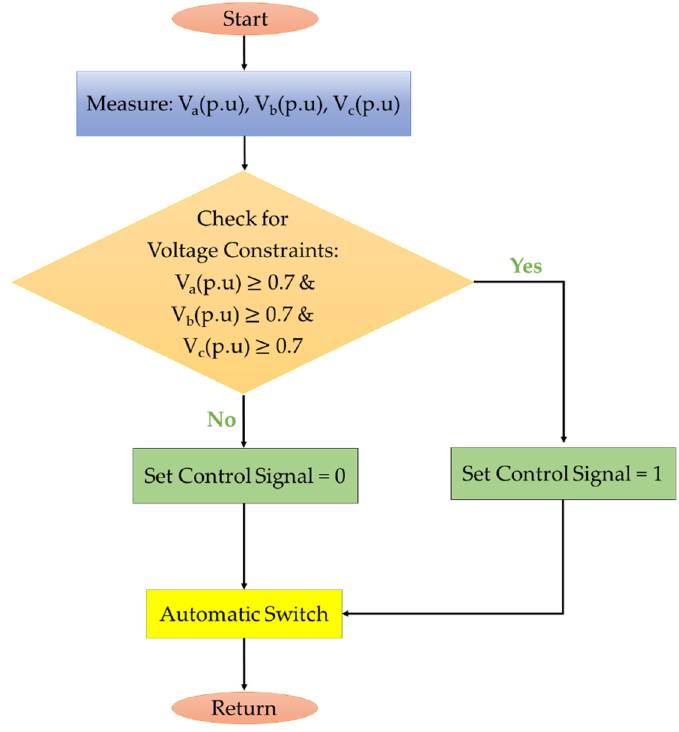
Figure 2. Block diagram of the proposed crowbar technique.